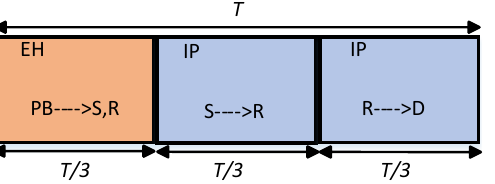
Figure 2. Transmission time frame of the considered wireless-powered system. The transmission frame is assumed to be equally-partitioned into three time slots for EH and information process- ing